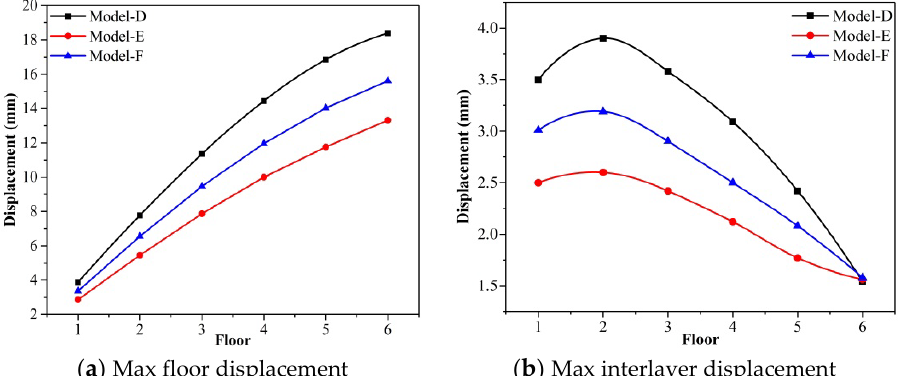
Figure 10. The floor displacement and interlayer displacement in the Y-direction.